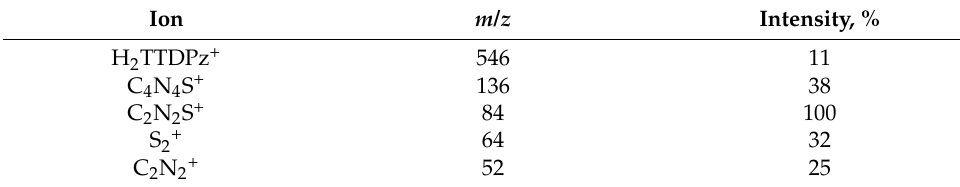
Figure 1. Mass spectrum of H 2 TTDPz recorded at 690 K. Table 1. Relative abundance of ions from H 2 TTDPz at 690